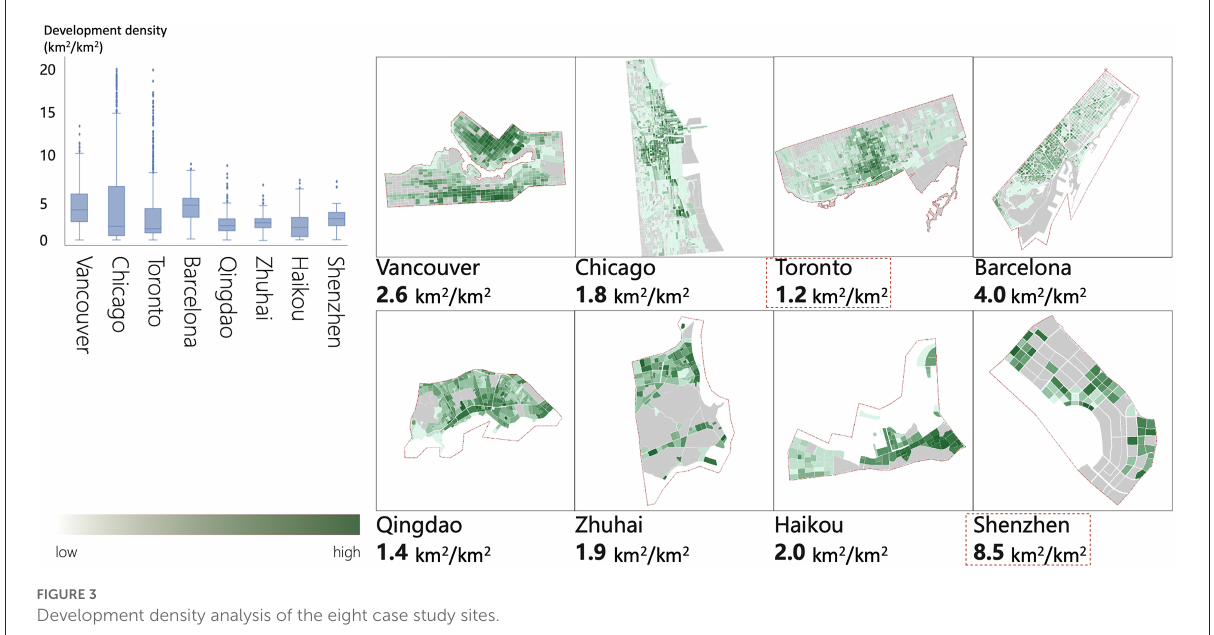
FIGURE3 Development density analysis of the eight case study sites.